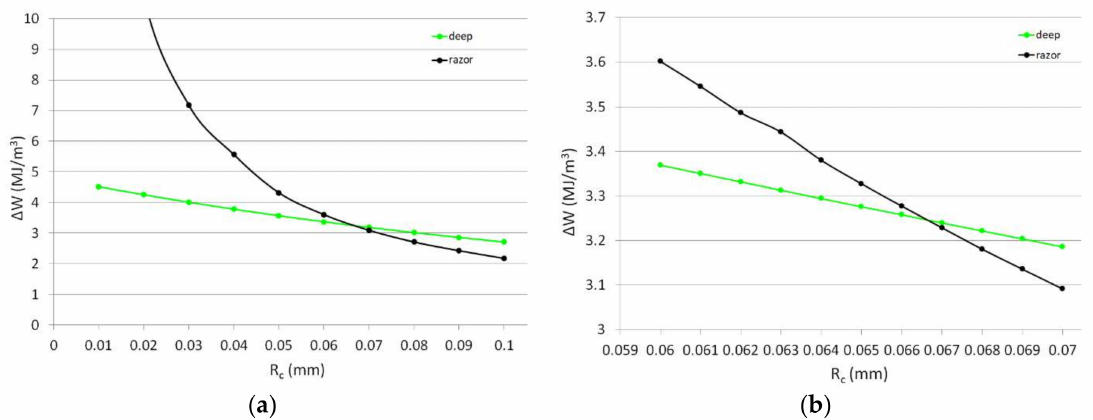
Figure 2. Determination of the SED critical parameters. The value of the critical radius R C has been varied with a step of 0.01 mm ( a ) and then with a finer step of 0.001 mm ( b ).